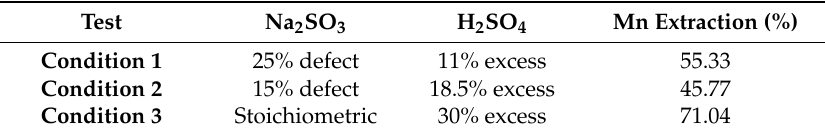
Table 4. Low temperature process after 90 s